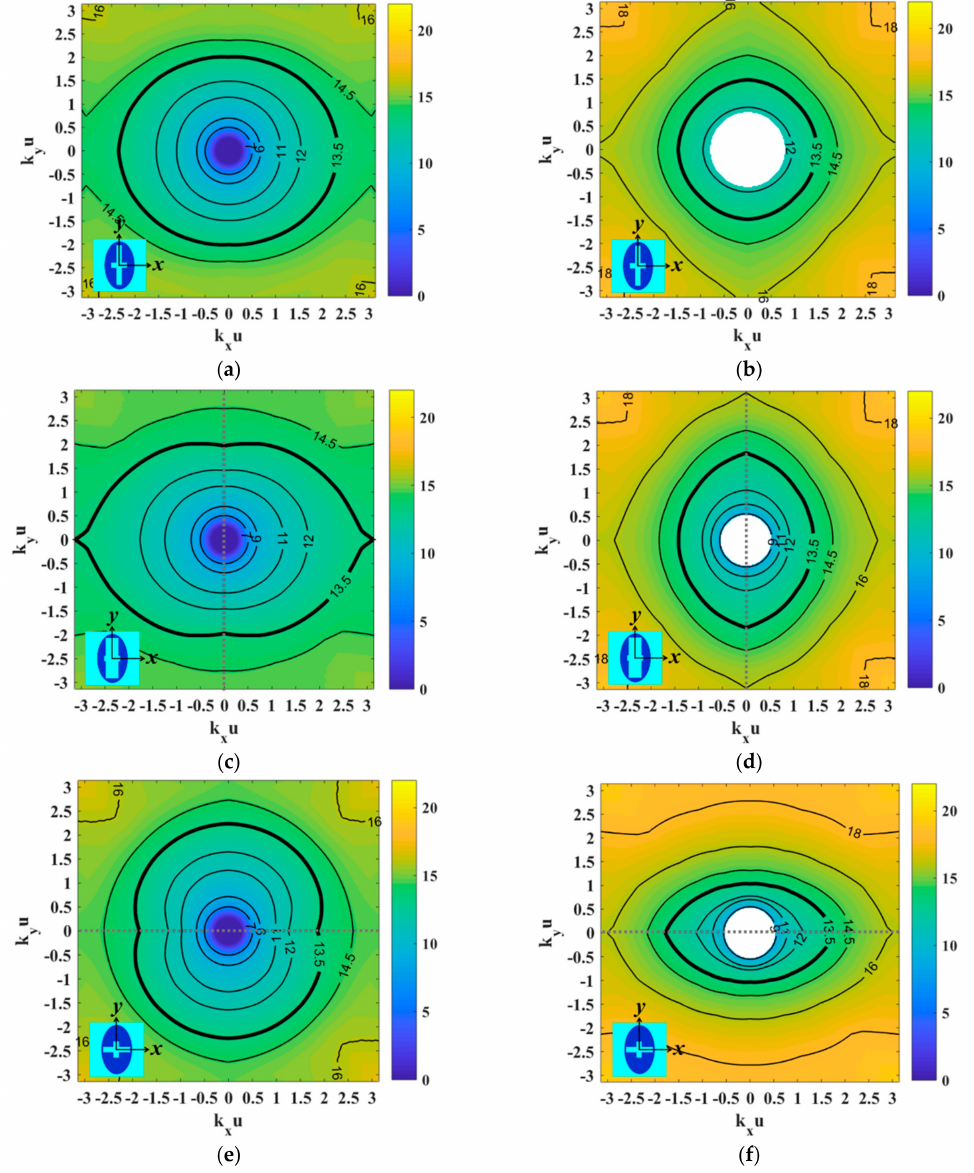
Figure 4. Frequency and spatial dispersion curves for TM (left column) and TE (right column) SWs supported by three different pixels composed by a metallic elliptical patch with an asymmetric aperture in the center, printed on a grounded dielectric. The ellipse ratio for the patches is e a / e b = 0.85 in all cases, and cross apertures are defined by ( w a / u , c a / e a , w b / u , c b / e b ) parameters: ( a , b ) pixel A (0.15, 0.6, 0.15, 0.9), ( c , d ) pixel B (0.25, 0.6, 0.15, 0.9) and ( e , f ) pixel C (0.15, 0.85, 0.15, 0.6). The employed dielectric is AD-1000 ( ε r = 10.2, thickness h = 1.27 mm) and the unit cell dimension u = 3.14